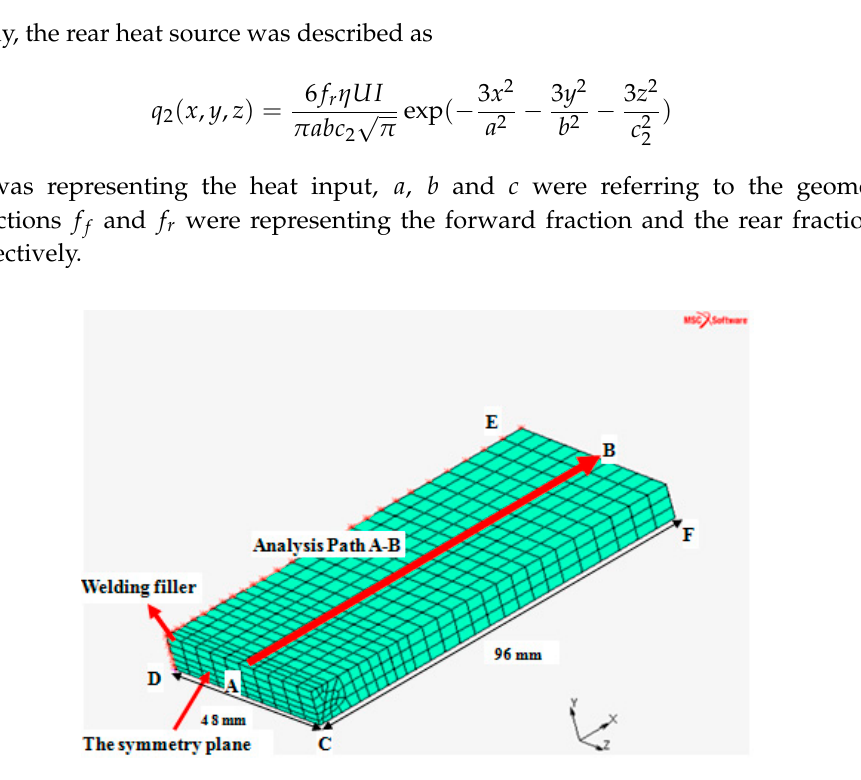
Figure 2. FE model of the MIG butt welded joint.